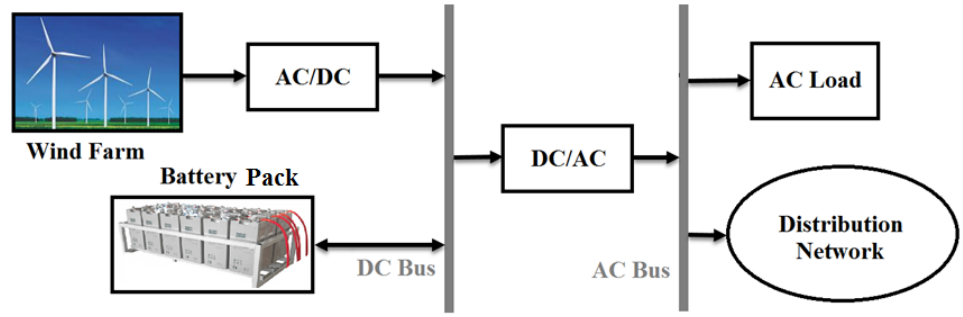
Figure 1. Interconnection of the hybrid WT/Battery energy system and the radial distribution sys- tem.